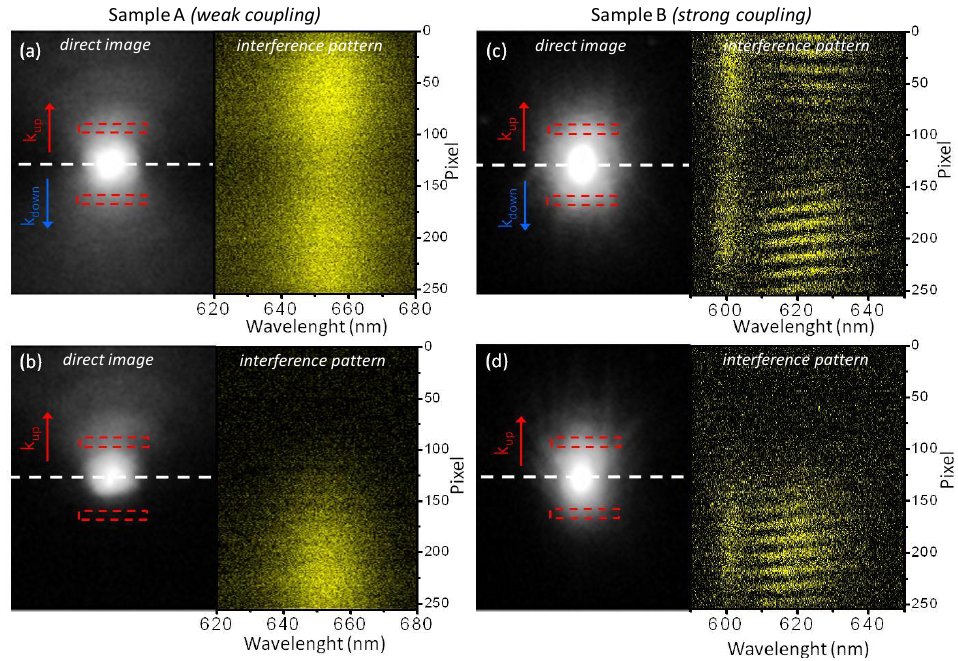
Figure 6. Direct imaging of the surface leakage radiation together with the associated interference pattern recorded for two samples: CdSe nanocrystals in weak coupling with the surface plasmon recorded in ( a ) k in strong coupling regime with the surface plasmon recorded in ( c ) k detection